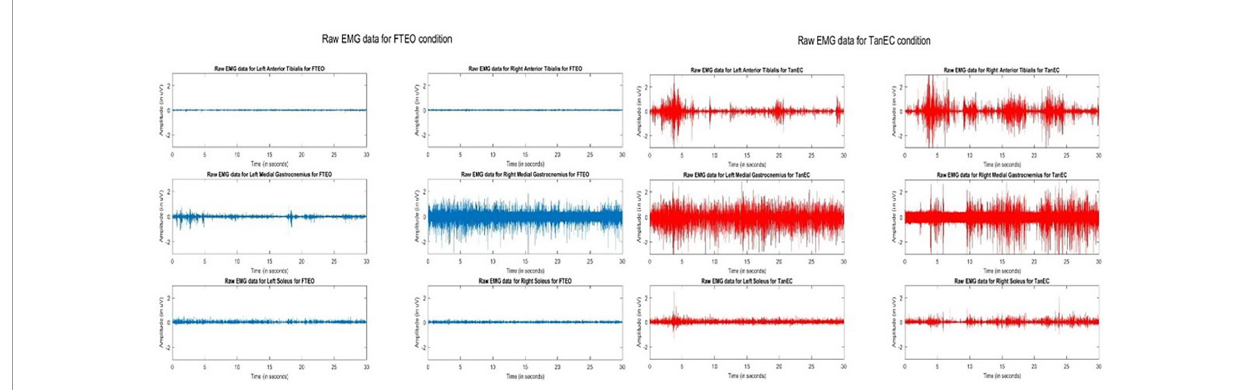
FIGURE1 Raw EMG signals of AT, MG, and S from both legs during standing balance under most stable position FTEO (in blue) and least stable position TanEC (in red) from a single trial from one participant. The image shows how the amplitude of EMG signals change from the most to the least stable postural standing positions.